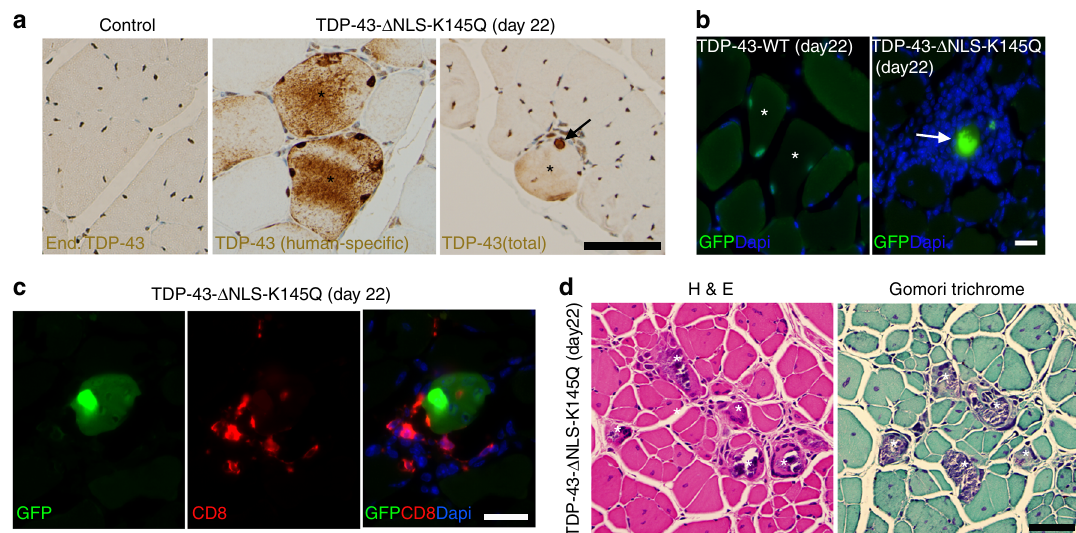
Fig. 5 Chronic TDP-43 pathology that persists in skeletal muscles recapitulates aspects of sIBM pathology. Mouse TA muscles were mock treated (control) or electroporated with GFP-tagged TDP-43-WT or TDP-43- Δ NLS-K145Q for 22 days. a Muscle sections were analyzed by immunohistochemistry using a monoclonal TDP-43 antibody detecting the ectopically expressed TDP-43 construct (human-speci fi c TDP-43 antibody) or a polyclonal TDP-43 antibody detecting total TDP-43 (endogenous mouse or ectopic human TDP-43). Both antibodies detected TDP-43 aggregates ( black asterisks and arrows ). Scale bar = 50 μ m. Muscle sections were also analyzed by standard GFP fl uorescence ( b ) or double-labeled with GFP ( green ) and CD8 ( red ) antibodies ( c ), while nuclei were stained with DAPI. Scale bar = 20 μ m. d H&E and Gomori trichrome staining showed robust myo fi ber pathology associated with chronic TDP-43 aggregation ( white asterisks ). Scale bar = 50 μ